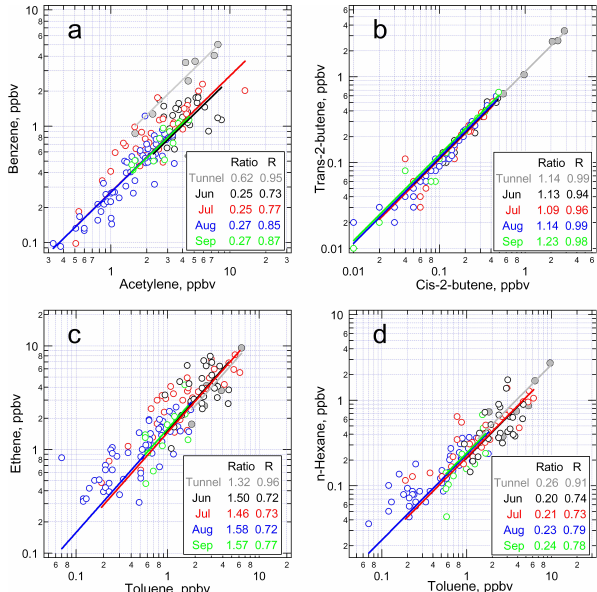
Fig. 4. Ratios and linear correlation coefficients ( R ) between (a) benzene and acetylene, (b) trans-2-butene and vis-2-butene, (c) ethene and toluene, and (d) n-hexane and toluene during June (in black), July (in red), August (in blue), and September (in green), and comparison with the results of 2009 tunnel study (in grey).